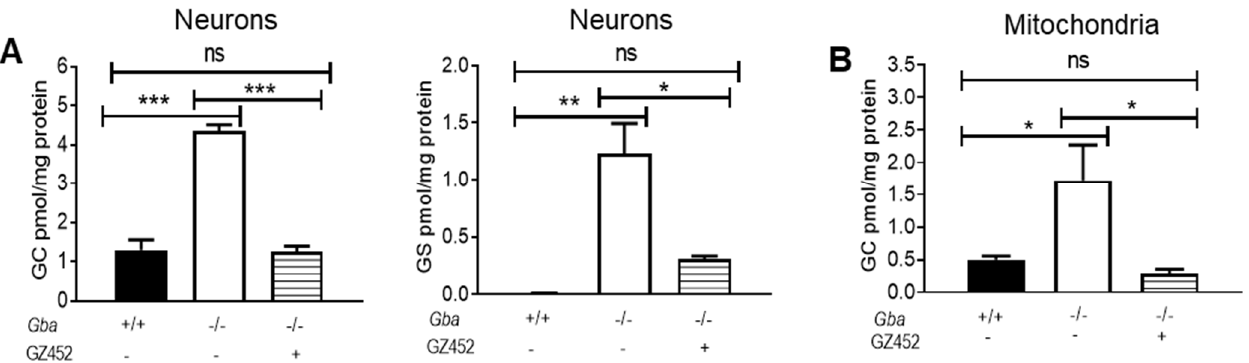
Figure 1. Glucosylceramide (GC) and glucosylsphingosine (GS) analysis by LC/MS-MS in neurons and isolated mito- chondria. ( A ) GC and GS levels in Gba -/- neurons were significantly reduced by 300 nM GZ452 treatment. ( B ) In the isolated mitochondria, GC level in GZ452-treated Gba -/- neurons was reduced to WT ( Gba +/+ ) level. Triplicate experiments ( n ≥ 2–4 samples). One-way ANOVA (* p < 0.05; ** p < 0.01; *** p < 0.001). ns, not statistically